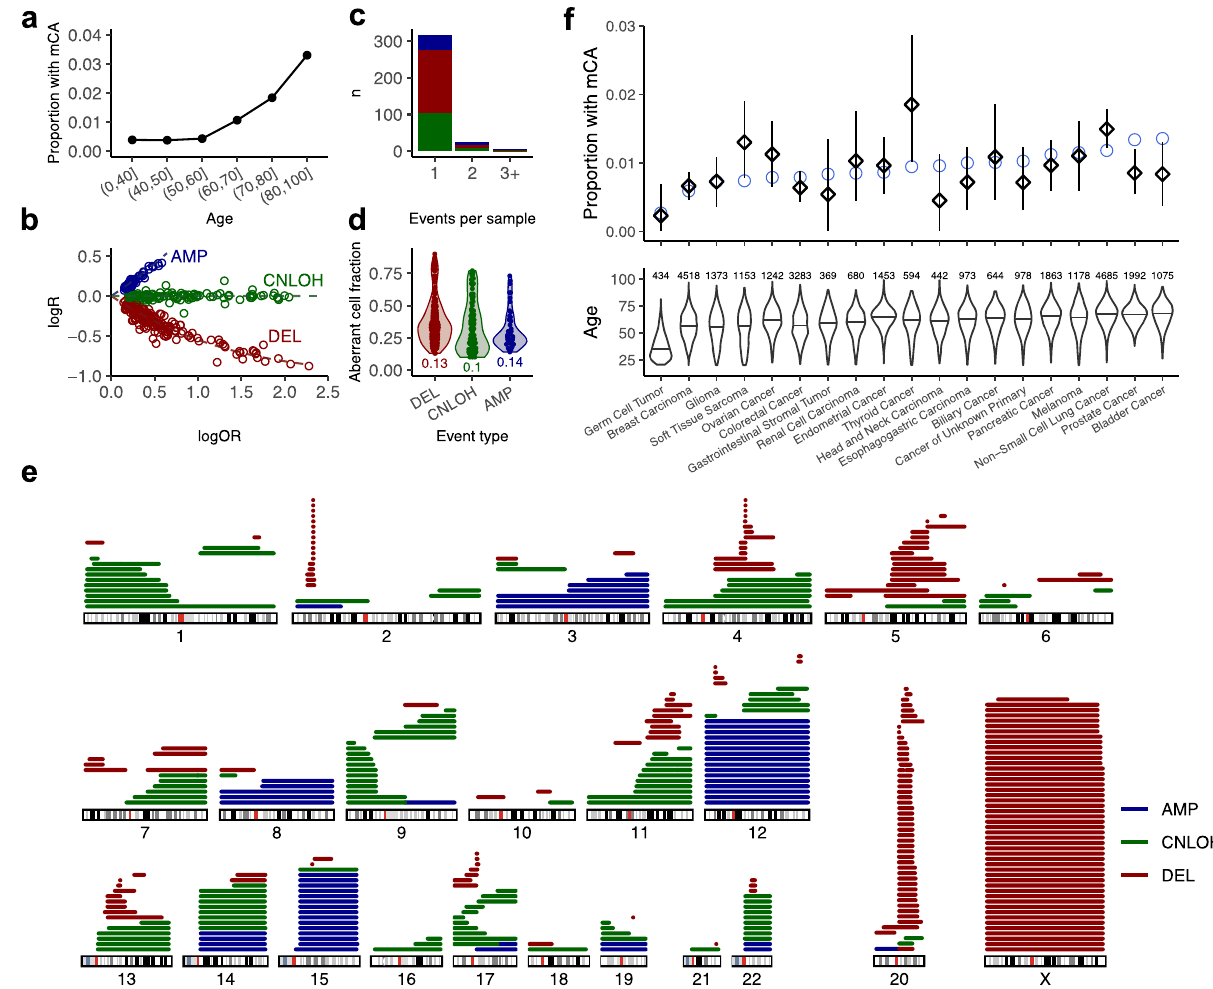
Fig. 1 Landscape of mCA in the MSK-IMPACT cohort. a Proportion of subjects with detected mCA increases with age. b Classi fi cation of events by copy number states. logR: log 2 ratio of the coverage depth between analyzed sample and normal comparison. logOR: log allelic ratio between major and minor alleles in heterozygous SNP loci. Events are colored by inferred alteration type. c Number of subjects with 1, 2, or 3 + mCAs. d Cell fraction of detected aberrant clones strati fi ed by alteration type. Numbers below the violins indicate the minimum. e Genome-wide distributions of detected mCAs. f Proportion of subjects with mCA among major cancer types. Squares: observed incidence. Blue circles: expected incidence. 95% CI are shown in black. Number of patients are displayed in the middle. Source data are provided as a Source Data fi